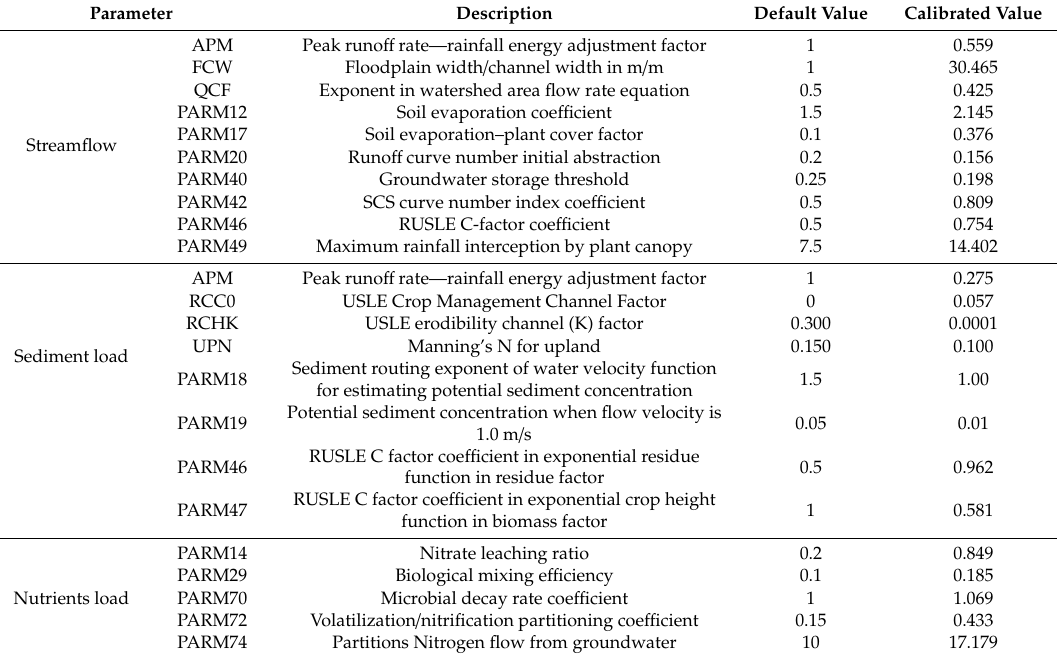
Table 5. Parameters identified in the sensitivity analysis used for the calibration and validation of streamflow, sediment load, nitrate nitrogen and total phosphorus